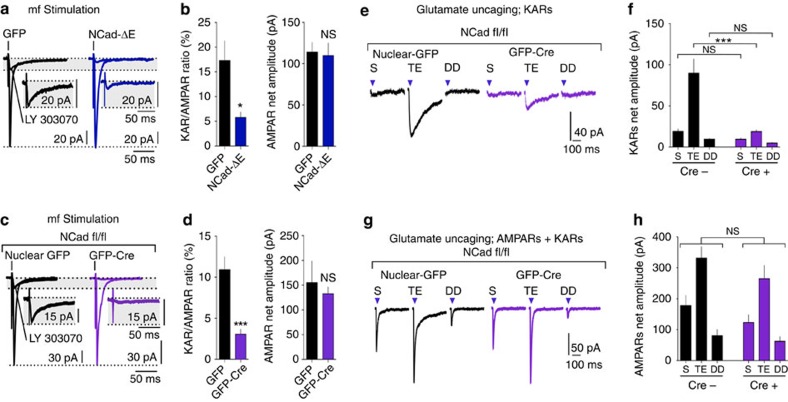
N-cadherin is necessary for the stabilization of synaptic KARs.(a,b) Averaged synaptic currents evoked by mf stimulation (3Hz) in WT CA3 PCs from organotypic slices transfected with GFP or NCad-ΔE (30 ng μl−1) in the absence and in the presence of 25 μM LY303070, to isolate the AMPAR and the KAR component, respectively. Insert enlargements of isolated KAR-EPSCs. Graphs summarizing KAR/AMPAR ratios and net amplitude of AMPAR-EPSCs obtained from experiments presented in a. GFP: n=6 cells; NCad-ΔE: n=6 cells; 7 mice. (c,d) Averaged synaptic currents evoked by mf stimulation (3Hz) in CA3 PCs from NCadflox/flox organotypic slices transfected with nuclear GFP or GFP-Cre (20 ng μl−1), in the absence and in the presence of 25 μM LY303070, to isolate AMPAR and KAR-EPSCs, respectively. Insert, enlargements of isolated KAR-EPSCs. Graphs summarizing KAR/AMPAR ratios and net amplitudes of AMPAR-EPSCs obtained from experiments in c. Nuclear-GFP: n=7 cells; GFP-Cre: n=6 cells; 8 mice. (e,f) Sample traces illustrating KAR currents evoked by glutamate uncaging (25 μM LY303070) in different compartments (S, TE and DD) of CA3 PCs from NCadflox/flox organotypic slices electroporated either with nuclear-GFP or GFP-Cre. Graph summarizing average net amplitude of evoked KAR currents. Nuclear-GFP; uncaging sites: S, n=11; TE, n=11; DD, n=10. Experiments performed on 11 cells, 6 slices and 4 mice. GFP-Cre; uncaging sites: S, n=8; TE, n=8; DD, n=8. Experiments performed on eight cells, four slices and four mice. (g,h) Sample traces illustrating AMPAR–KAR currents evoked by glutamate uncaging in different compartments of CA3 PCs (S, TE and DD) from NCadflox/flox organotypic slices electroporated with either nuclear-GFP or GFP-Cre (S, TE and DD). Graph summarizing average net amplitude of evoked AMPAR–KAR currents. Nuclear-GFP; uncaging sites: S, n=9; TE, n=9; DD, n=8. Experiments performed on nine cells, four slices and four mice. GFP-Cre; uncaging sites: S, n=8; TE, n=8; DD, n=8. Experiments performed on eight cells, four slices and four mice. All experiments include bicuculline (10 μM), D-AP5 (50 μM) and NBQX (150 nM). In all panels, values are presented as mean ±s.e.m. of n experiments. Data were compared using unpaired t-test (NS, not significant; P>0.05, *P<0.05 and ***P<0.001).